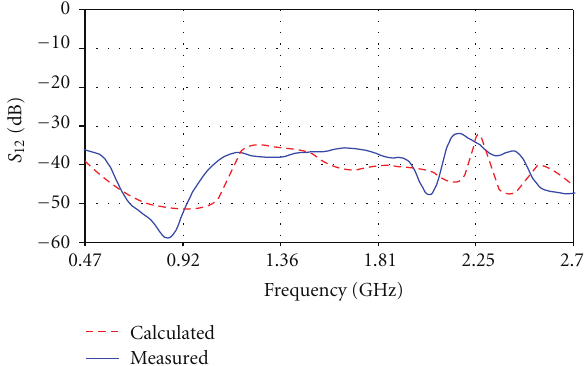
Figure 9: Mutual coupling ( S 12 ) between the antennas of the first configuration while the antennas are perpendicular to each